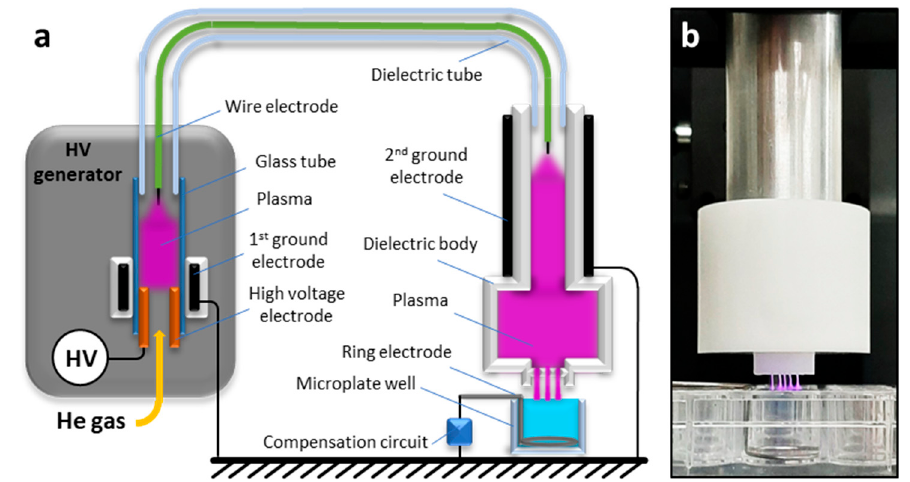
Figure 9. Schematic representation ( a ) and photo ( b ) of the NTP device with a multi-jet